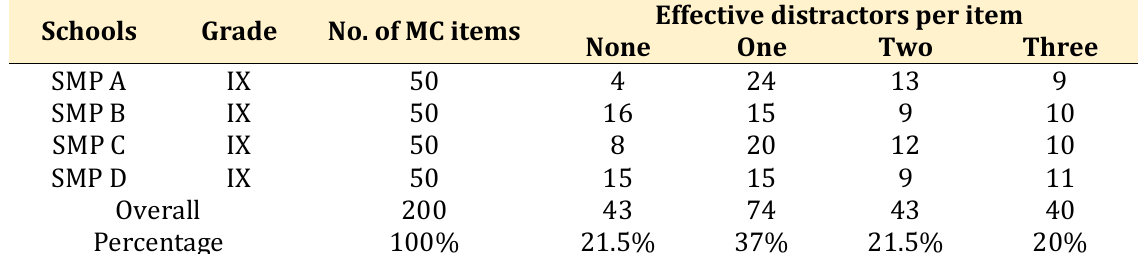
Table 5. Distractor Power of the